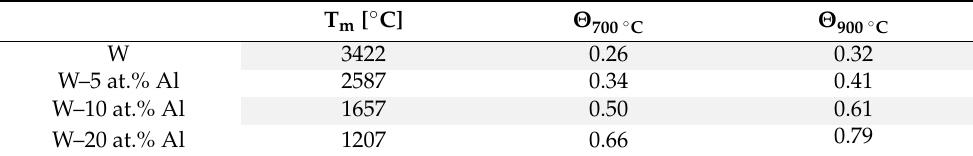
Table 1. Melting temperature and homologous temperatures at 700 ◦ C and 900 ◦ C of W and selected W-Al alloys. T m [ ◦ C] Θ 700 ◦ C W 3422 W–5 at.% Al 2587 W–10 at.% Al 1657 W–20 at.% Al 1207 0.66